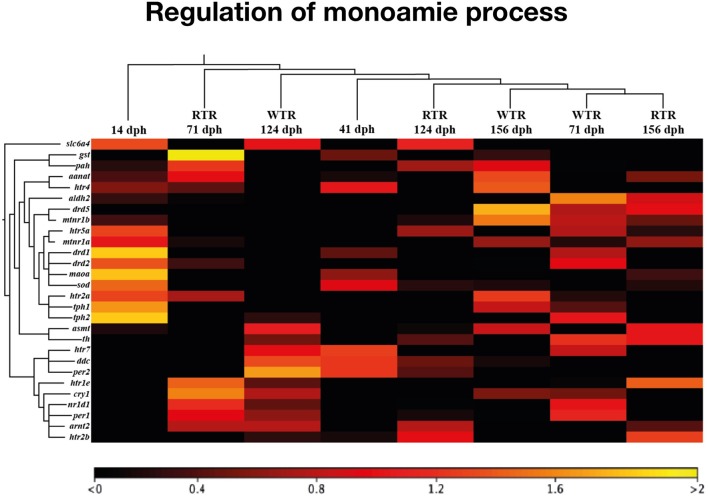
Heatmap representing the expression profile of 28 differentially expressed genes in Salmo salar brain during development (156 days post-hatching). Experimental groups are restricted thermal range (RTR, ΔT 1.4°C) and wide thermal range (WTR, ΔT 6.8°C). Transcript abundance is represented as color scales show relative transcript expression in RPKM values.